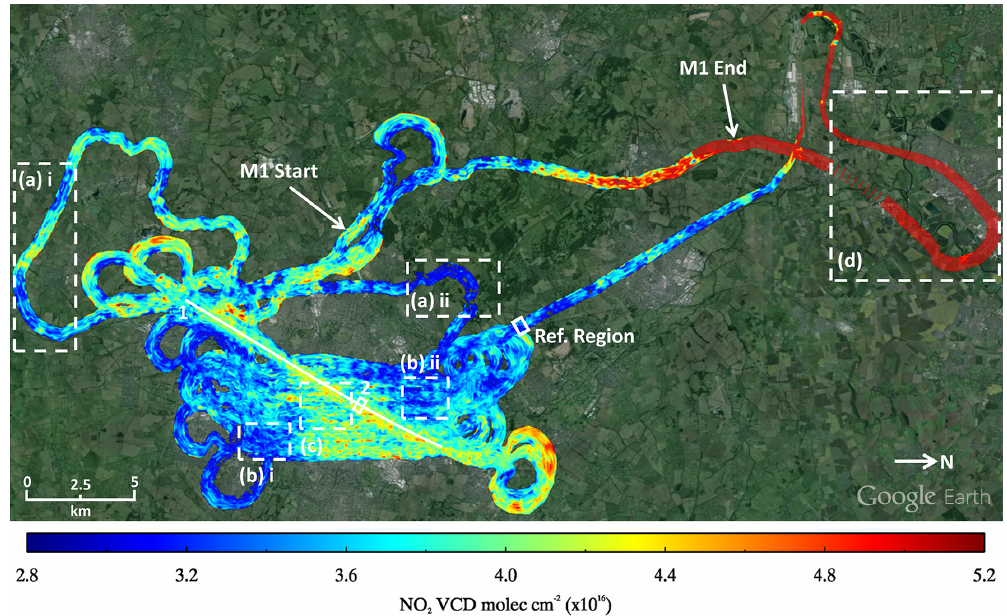
Figure 13. Complete ANDI data set from the test flight plotted in Google Earth with features of interest and areas used for regional averages highlighted. Coordinates for these regions are provided in Table 5. The gap in the data just prior to the power station is caused by the CompAQS spectrometer failing for 46s. The single scans downwind of the power station are from the instrument temporarily stopping and starting because of an issue with the control software.